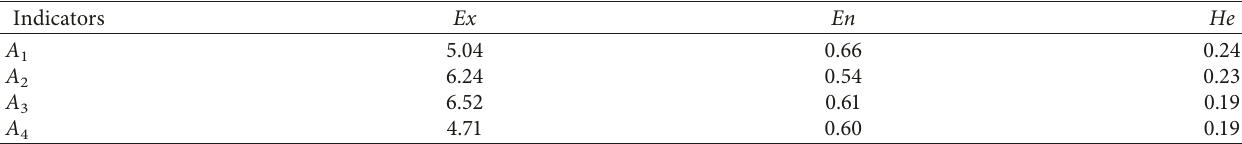
Table 7: First-level indicators of section ZK70+875 ∼ ZK71 +005.